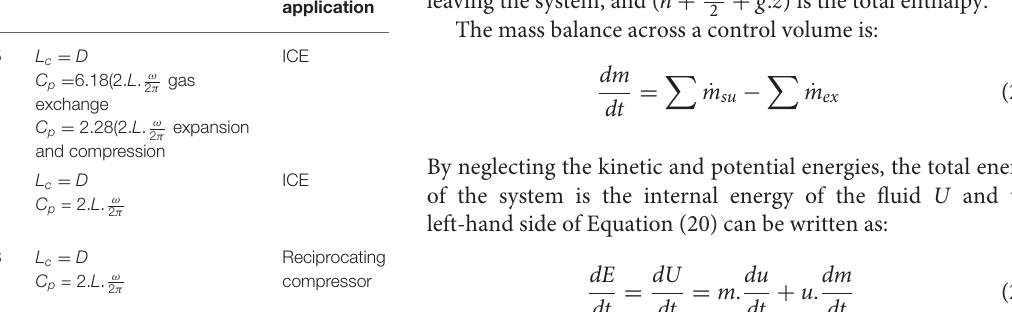
TABLE 3 | Heat transfers correlation parameters values.